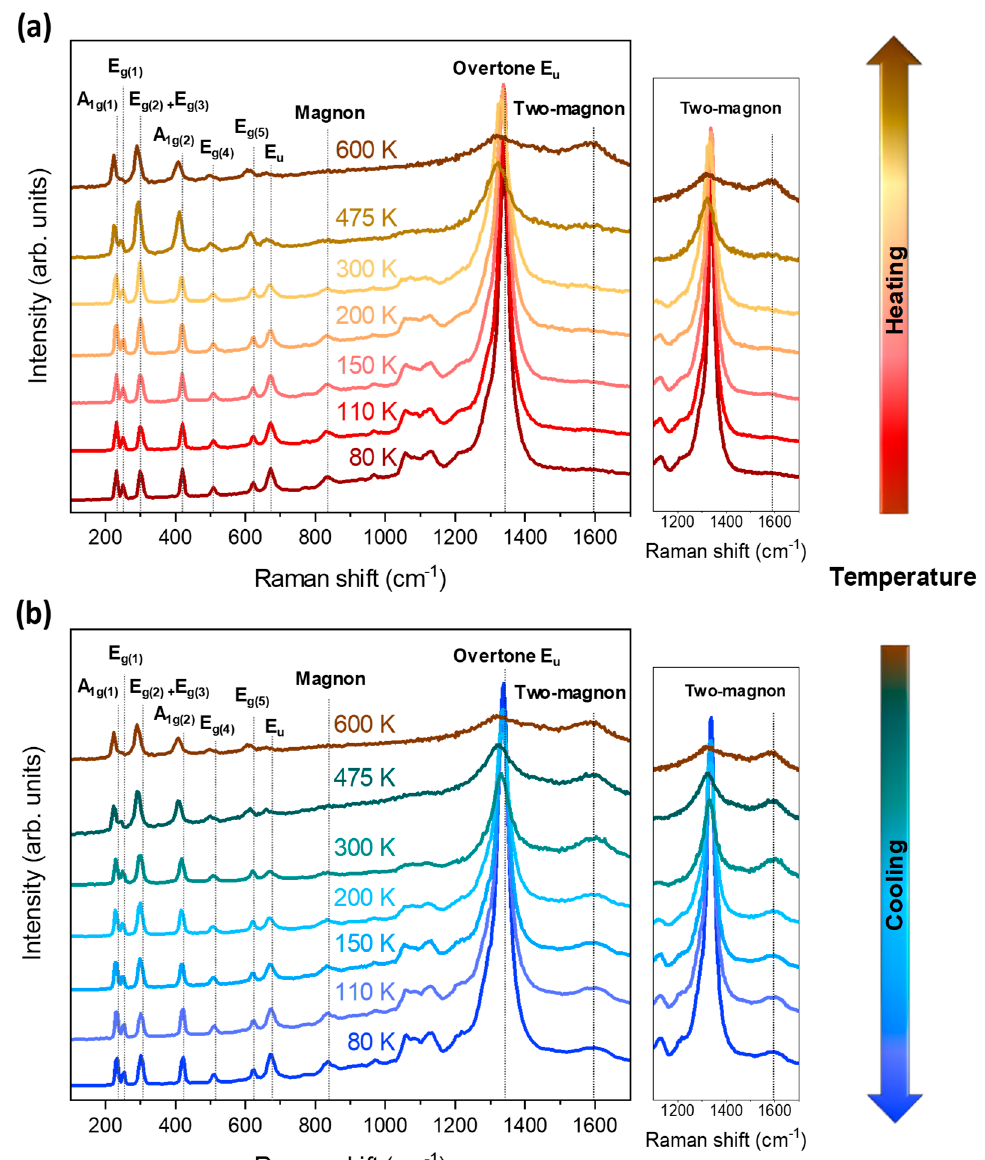
Figure 4. ( a ) Heating and ( b ) cooling thermal evolution of the Raman spectra between 80 and 600 K related to the nanoparticulated hematite coating grown on a silica substrate. Dashed vertical lines are added for clarity and the indexation of the respective modes. In addition, a magnification of the two-magnon region is shown at the right of the Figure a and b, respectively. The Raman spectrum recorded at 600 K is the same for the heating and cooling evolutions.